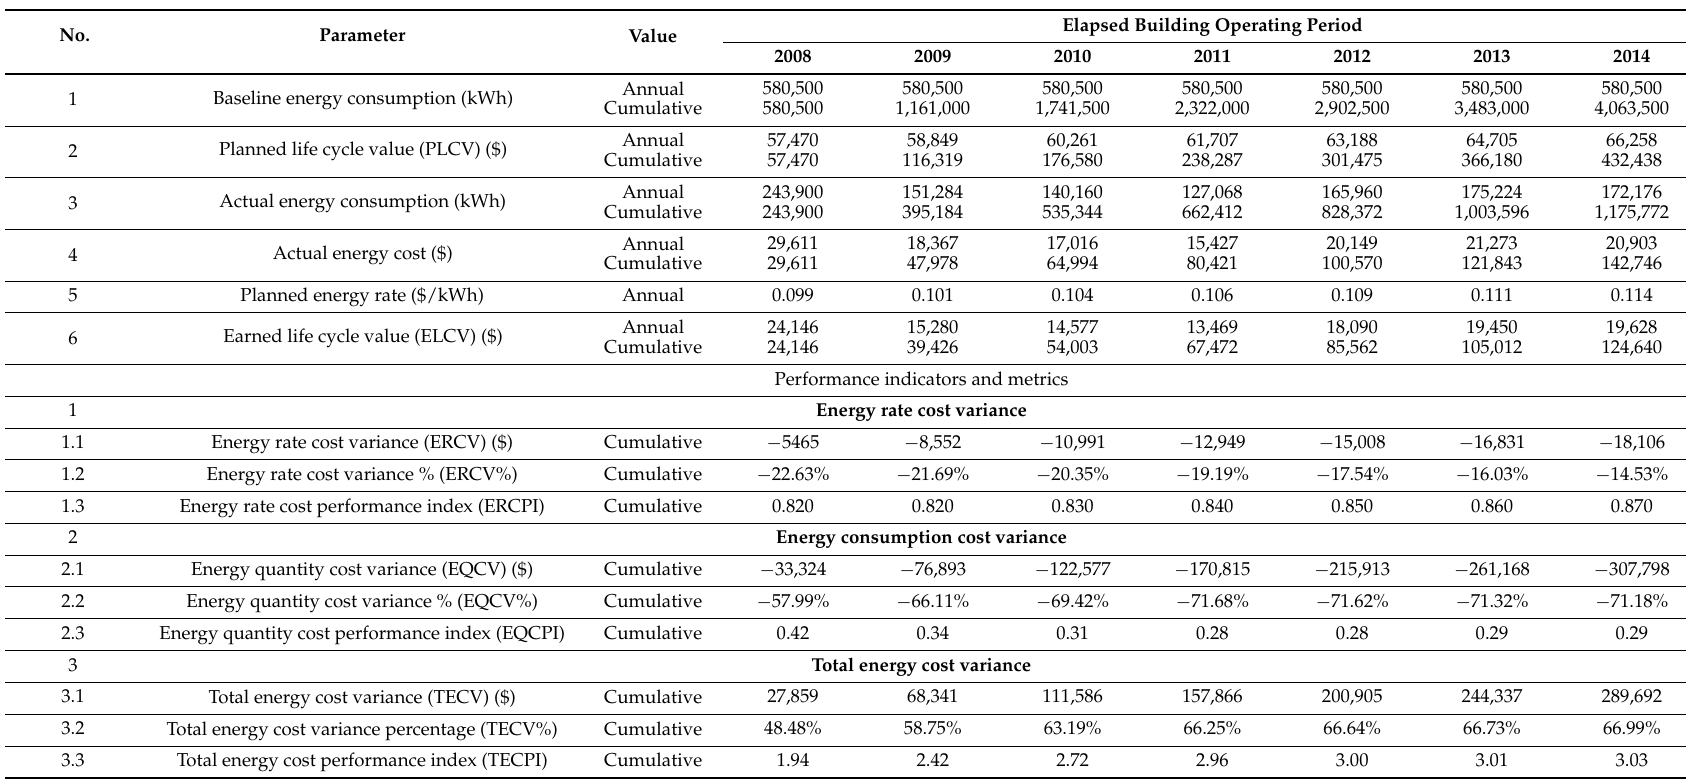
Table 5. Energy cost performance measurement using the earned value